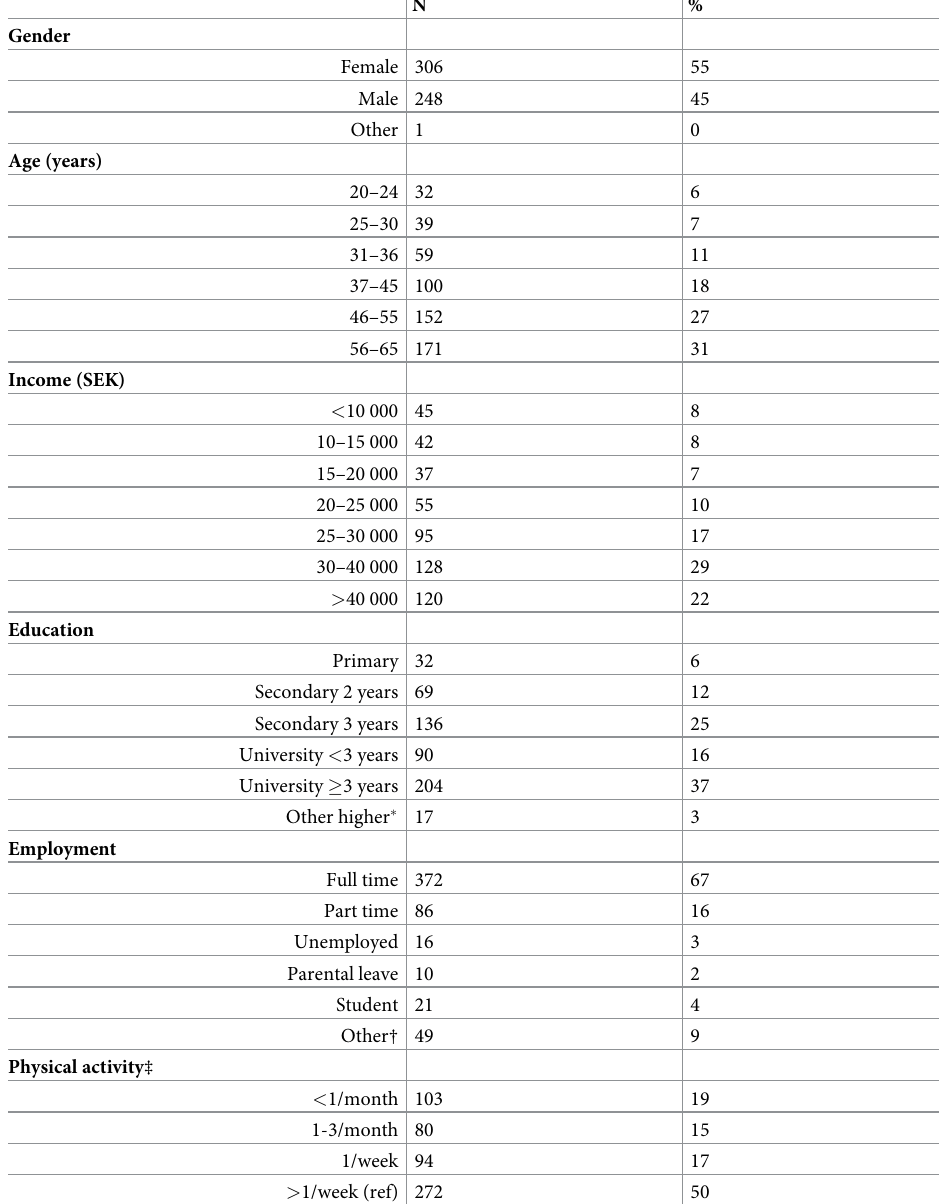
Table 1. Characteristics of the 555 study participants in the SWEDIET-2017 study.